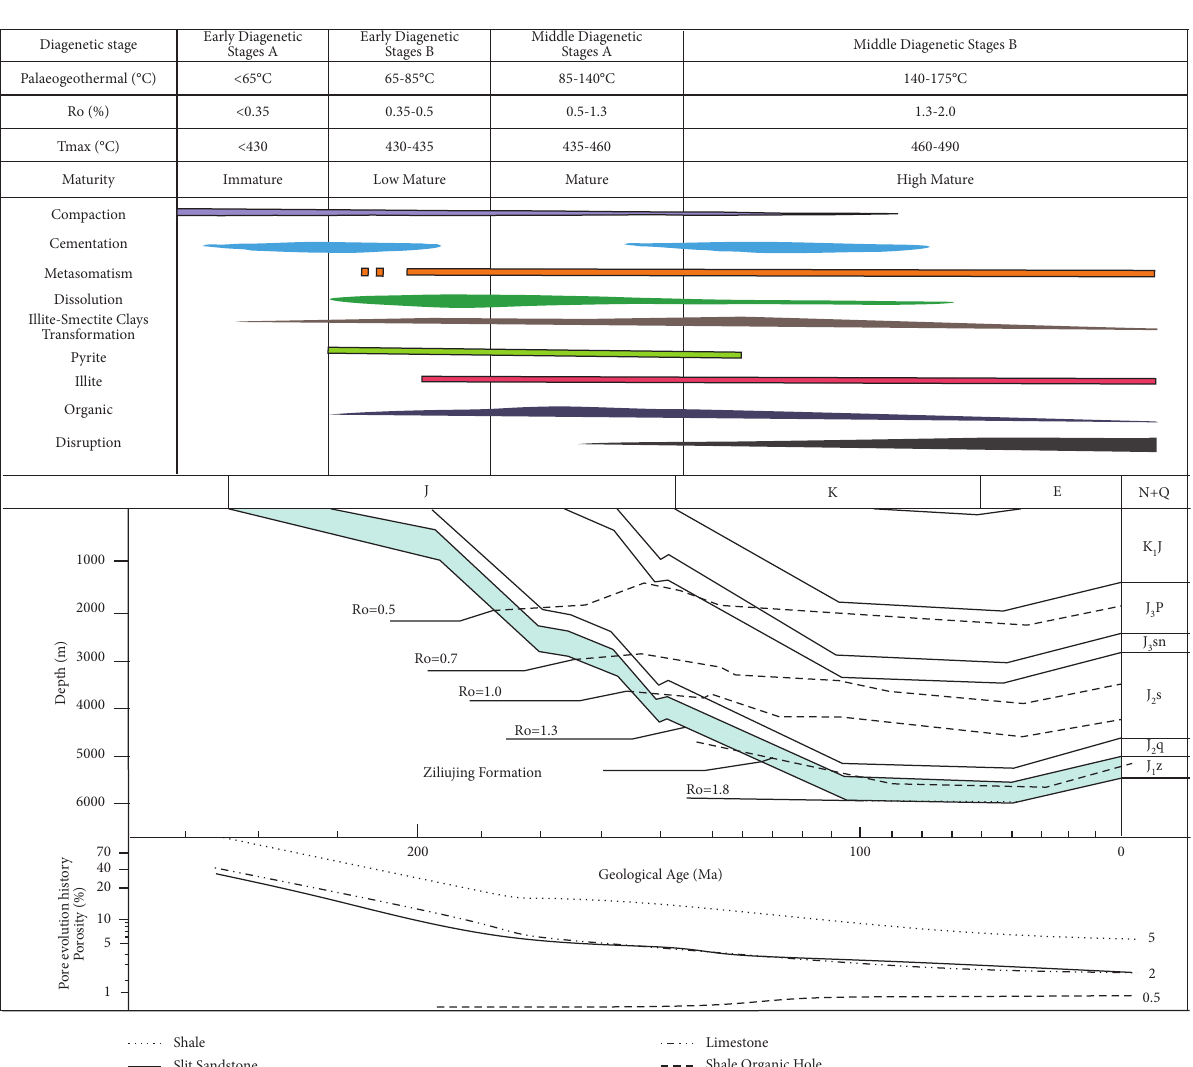
Figure 9: Diagenetic evolution sequence of Da’anzhai Member of Jurassic Ziliujing Formation in Sichuan